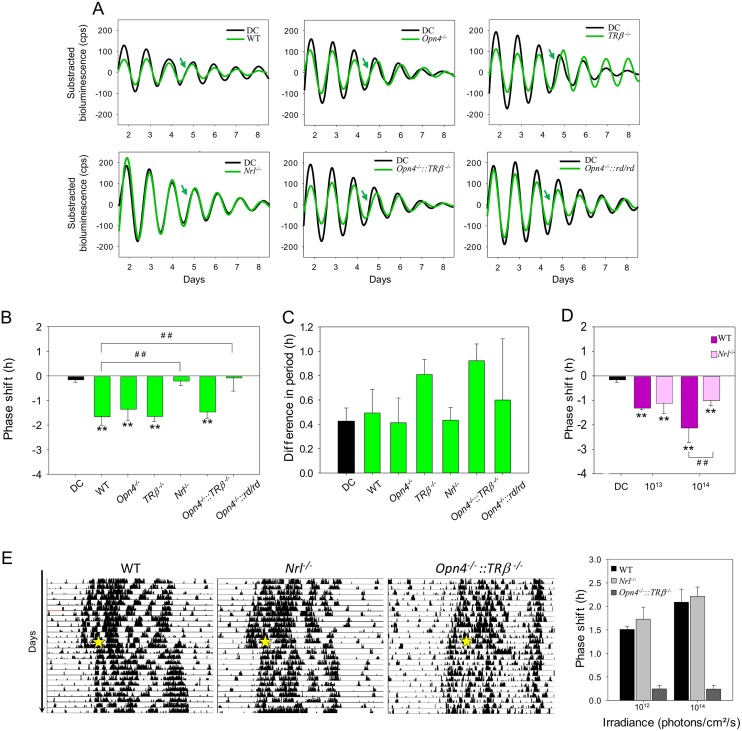
Light response of the retinal clock in WT Per2Luc and photoreceptor-deficient (Opn4−/−::Per2Luc, TRβ−/−::Per2Luc, Nrl−/−::Per2Luc, Opn4−/−::TRβ−/−::Per2Luc, and Opn4−/−:: rd/rd::Per2Luc) mice.A. Representative PER2::Luc bioluminescence traces of retinal explants from Per2Luc and photoreceptor-deficient mice exposed to 520 nm (30 min, 1014 photons/cm2/s; green line) compared to DC (black line). Green arrows indicate CT16, the time of the stimulation. B. Mean light-induced phase shift in homozygous genotypes. C. Difference in the endogenous period before and after the light stimulation. A positive value corresponds to a lengthening of the period. Bars represent mean ± SEM (DC: n = 17; WT: n = 8; for homozygous photoreceptor deficient mice: n = 3–8). D. Mean light-induced phase shift in the WT and Nrl−/−::Per2Luc following a 395-nm light stimulation (30 min, 2.8 x 1013 and 2.8 x 1014 photons/cm2/s; DC: n = 17; WT: n = 8; Nrl−/−::Per2Luc: n = 10). *Represents statistical differences with the DC and #statistical differences between different genotypes. *P < 0.01, **, or # #P < 0.001. E. Representative actograms of locomotor activity of a WT, a Nrl−/−::Per2Luc, and an Opn4−/−::TRβ−/−::Per2Luc mouse exposed to 15 min pulses of 530 nm monochromatic light at CT16 (2.8 x 1014 photons/cm2/s; yellow star) and mean light-induced phase shift after a light stimulation at 2.8 x 1012 and 2.8 x 1014 photons/cm2/s. No statistical difference was observed between WT and Nrl−/−::Per2Luc mice, whereas Opn4−/−::TRβ−/−::Per2Luc mice exhibit a reduced phase shift at both irradiances. Bars represent mean ± SEM (WT: n = 6; Nrl−/−::Per2Luc: n = 5; Opn4−/−::TRβ−/−::Per2Luc: n = 3). The data used to make this figure can be found in S1 Data. CT, circadian time; DC, dark control; Nrl, retina-specific leucine zipper protein; Opn4, melanopsin; PER2::Luc, PERIOD2::Luciferase; TRβ, thyroid hormone receptor beta; WT, wild-type.